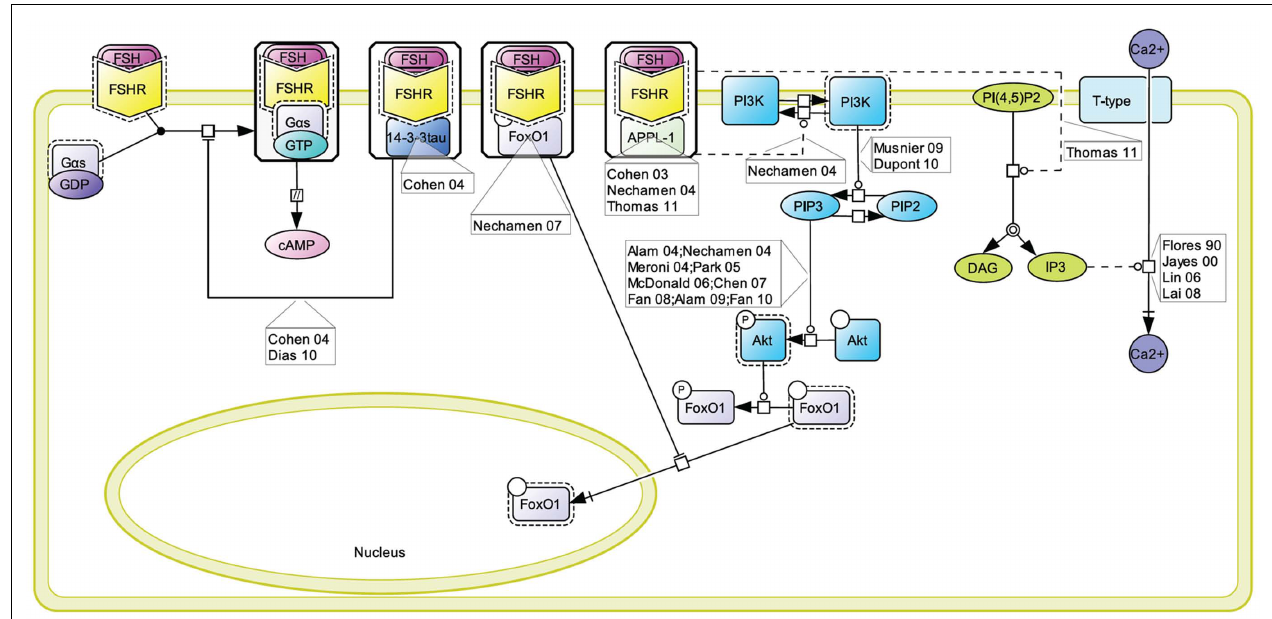
FIGURE 5 | Proteins interacting at the FSHR and their role in signaling. A number of proteins have been reported to interact with the FSHR and to impact on FSH-induced signaling pathways.These include 14-3-3 τ , FoxO1, and APPL1, the latter two being involved in the control of the PI3K/Akt pathway downstream of the